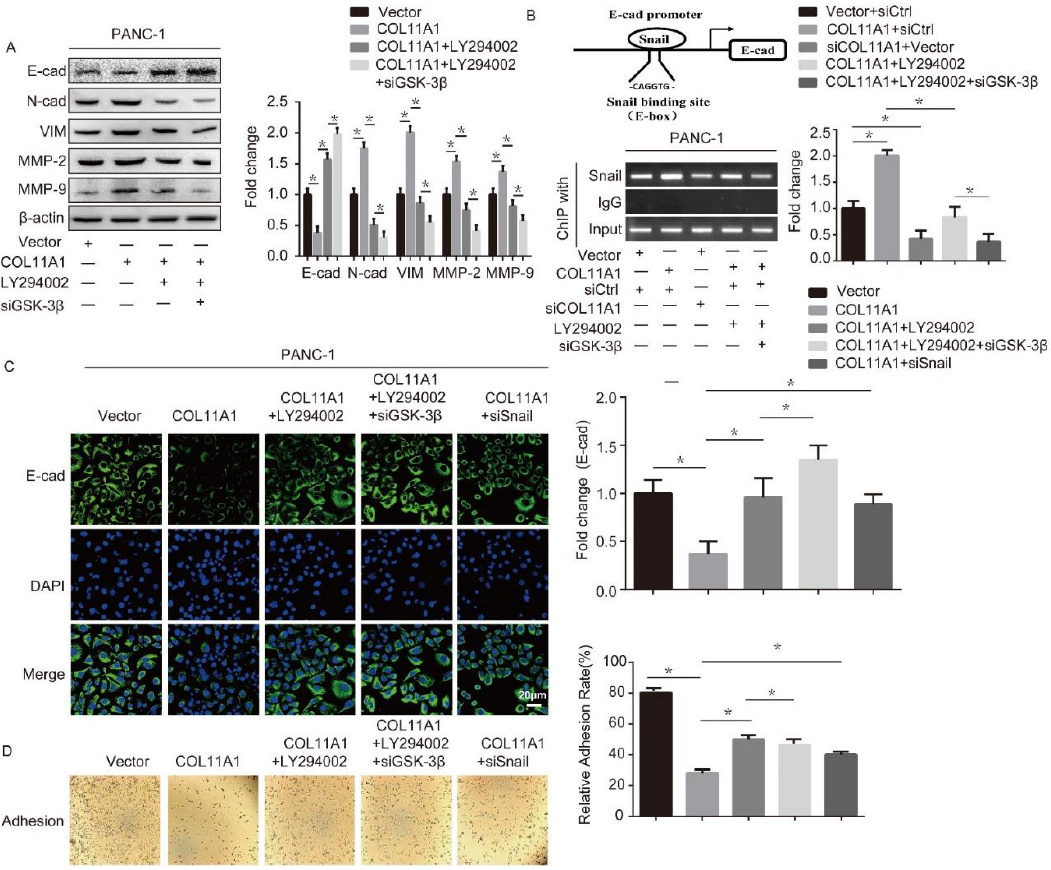
Figure 5. COL11A1 promoted EMT via the AKT/GSK-3 β /Snail signaling pathway: ( A ) Western blotting results showing the expression levels of EMT markers and MMP-2/9 in PANC-1 cells transfected with pCMV3-COL11A1, LY294002, and siGSK-3 β ; ( B ) the sequence and position of the Snail binding site in the E-cad promoter are shown. Chromatin immunoprecipitation (ChIP) of Snail in the E-cad promoter. PANC-1 cells were transfected withpCMV3-COL11A1, siCOL11A1, siGSK-3 β , and LY294002; ( C ) immunofluorescence analysis of E-cad expression levels in PANC-1 cells transfected with pCMV3-COL11A1, LY294002, siGSK-3 β , and siSnail ( × 100); ( D ) the images show the adhesion ability of the indicated cells after different treatments. ( n = 3, * p <